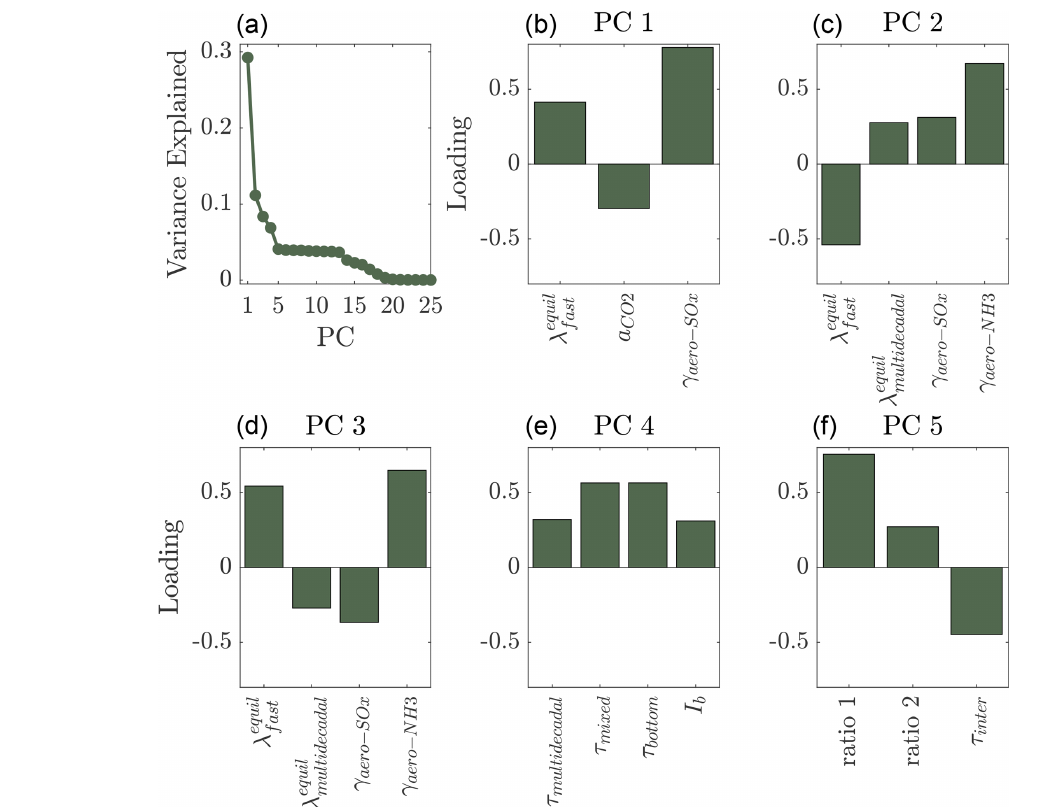
Figure 7. Principal component analysis of the posterior model ensembles. Shown is a scree plot of principal component (PC) vs. variance explained and PCs 1–5, simplified by showing only the model parameters with loading greater than 0.25 in magnitude. All 25 varied model parameters are fully defined in Table S1. Briefly, a_CO2 is the CO 2 radiative forcing coefficient; γ aero-XX terms reflect the sensitivity of radiative forcing to aerosol type XX; τ multi-decadal is the timescale for multi-decadal feedback; τ mixed , τ inter , and τ bottom are the ocean ventilation timescales for the ocean surface mixed layer, intermediate water, and bottom water, respectively; I b is the buffered carbon inventory of the air–sea system; ratio 1 is the ratio of warming for global surface temperatures relative to global sea surface temperatures at equilibrium; and ratio 2 is the ratio of warming for the whole ocean temperatures relative to sea surface temperatures at